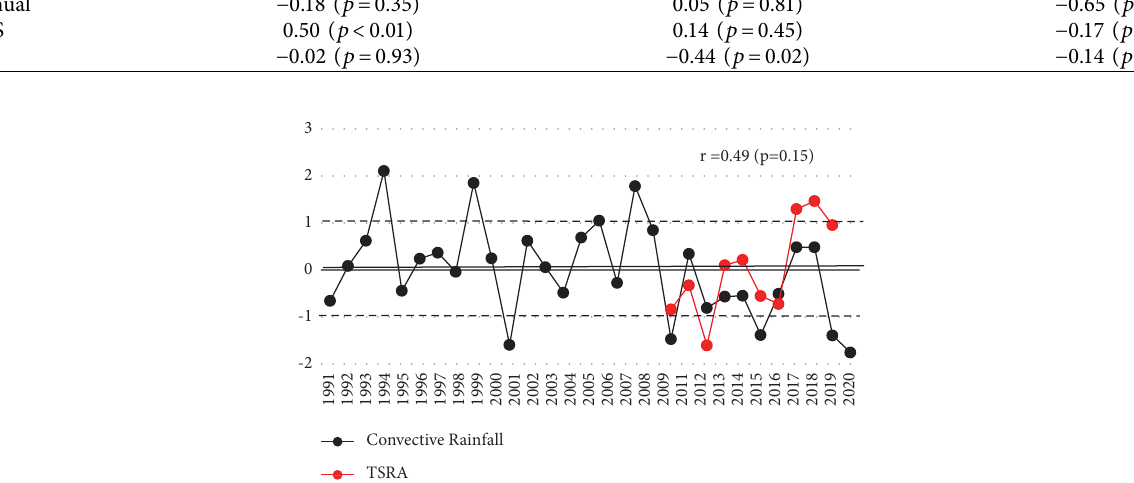
Figure 17: Interannual variability of standardized anomalies of TSRA occurrences (observation data) and convective rainfall (ERA5 reanalysis data) over the VYYY; the black line is the reference line and the black-dotted line bounds the value of ± 1 above or below years, assuming that there are exceeding or less years of convective rainfall over study area during 1991–2020.